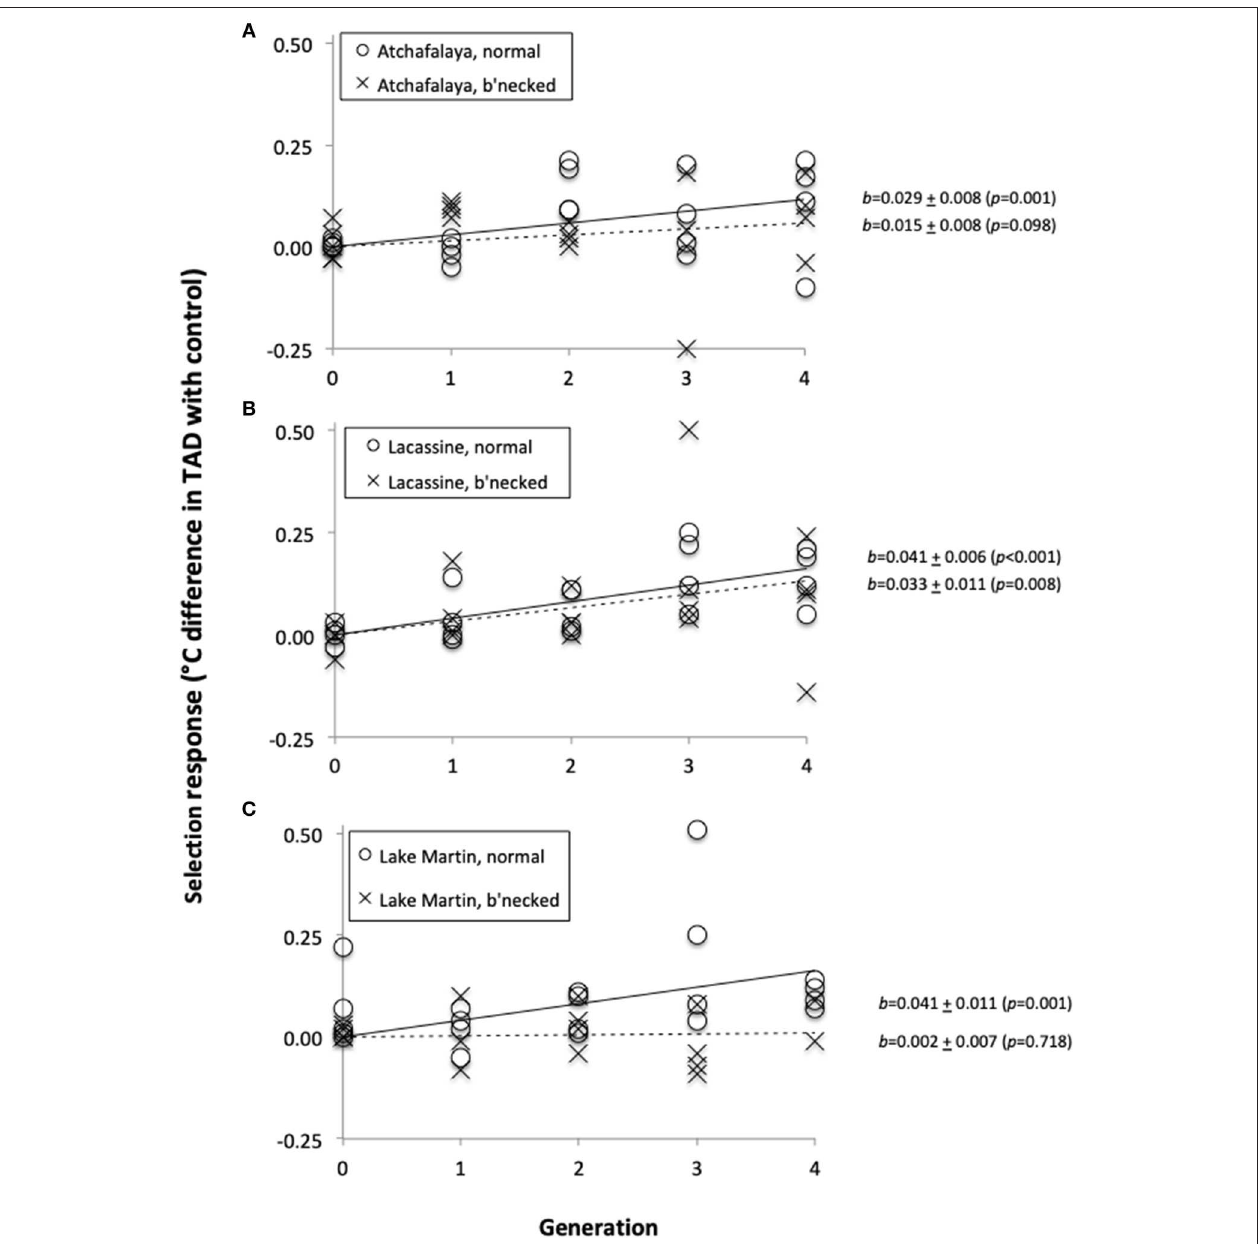
FIGURE 3 | Selection response (difference in temperature-at-death (TAD) between fish from a selection line and fish of its paired control line), as a function of generation number. Fish were from three source populations: Atchafalaya (A) , Lacassine (B) , and Lake Martin (C) . Open circles and solid regression lines represent normal populations, while crosses and broken regression lines represent bottlenecked populations.